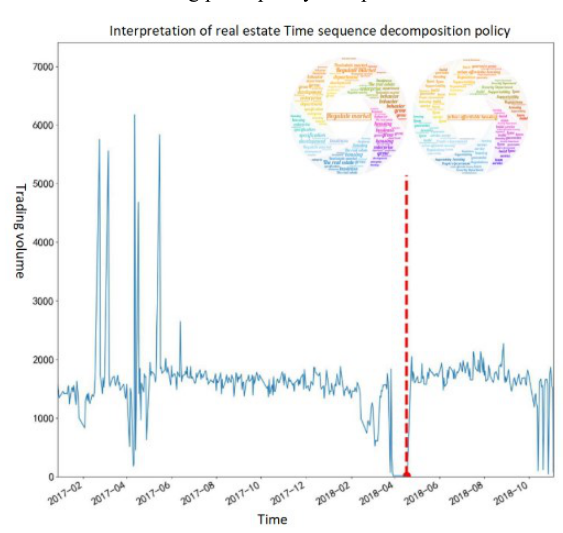
Figure 8. April 2018 Wuhan real estate transaction timing turning point policy